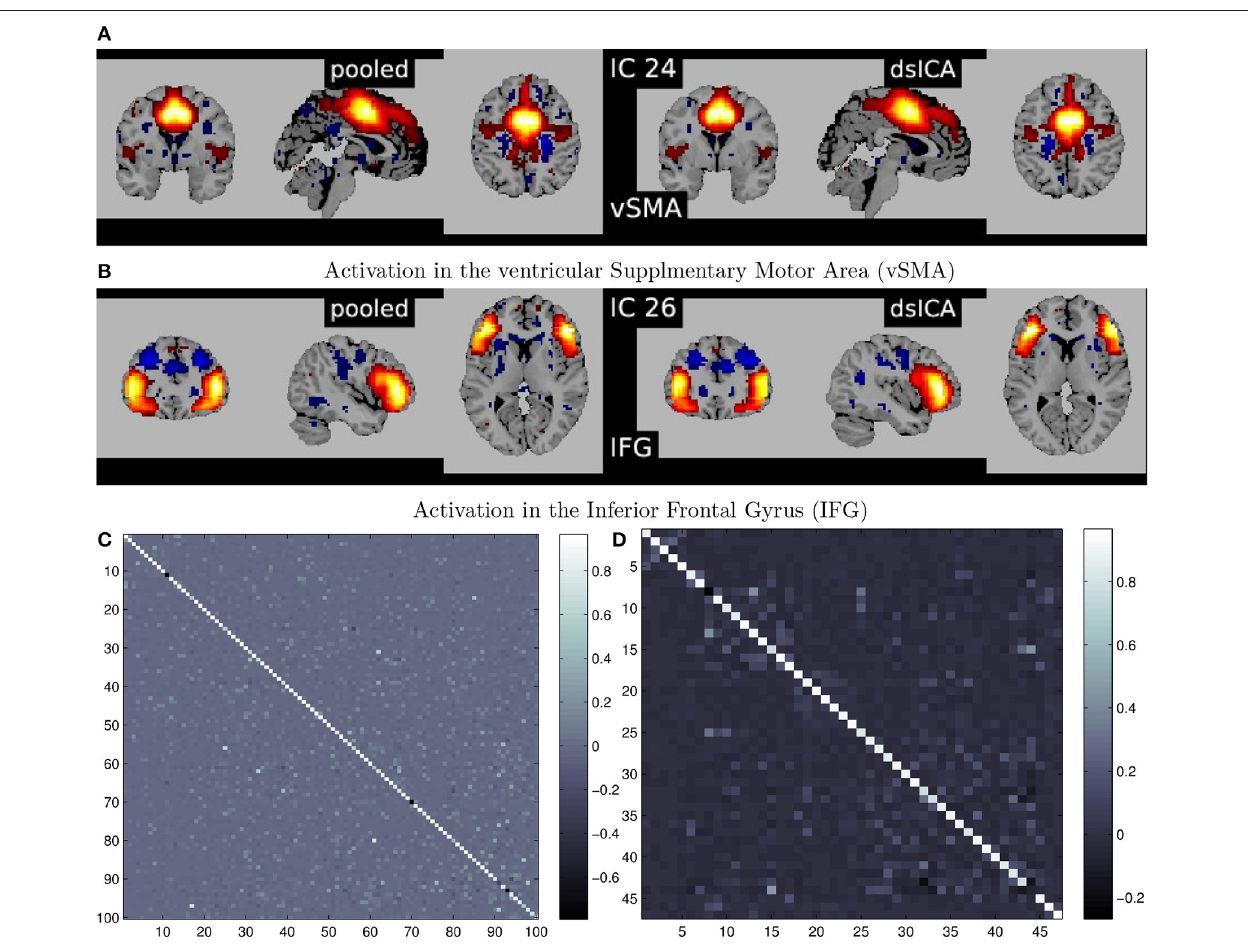
FIGURE 8 | (A,B) Illustrate examples of matched spatial maps from dgICA and pooled ICA. (C,D) Show the correlation of the components between pooled spatial ICA and dgICA after hungarian matching. (C) Shows correlation between all 100 components, and (D) Shows correlation between the 47 neurological components selected in Damaraju et al.